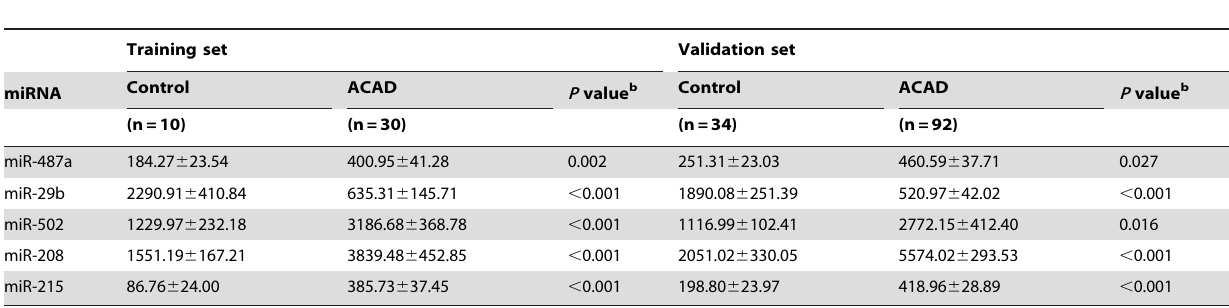
Table 2. Differentially-expressed miRNAs in Atypical coronary artery disease (ACAD) serum samples compared to control samples in training set and validation set a